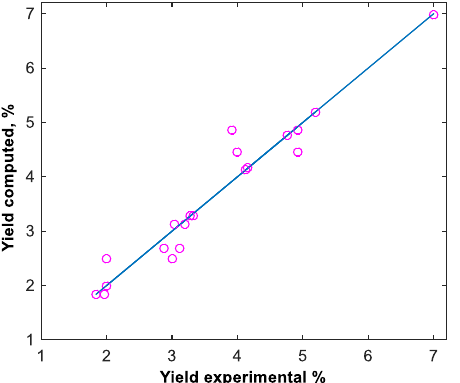
Figure 4. Parity plot for the experimental and computed data. From the point of view of how the network captured the characteristics of the process, the convergence variation in the training, validation, and testing stages is analyzed, by identifying the minimum errors between the measured and estimated yield values, during the learning cycles (Figure 5).